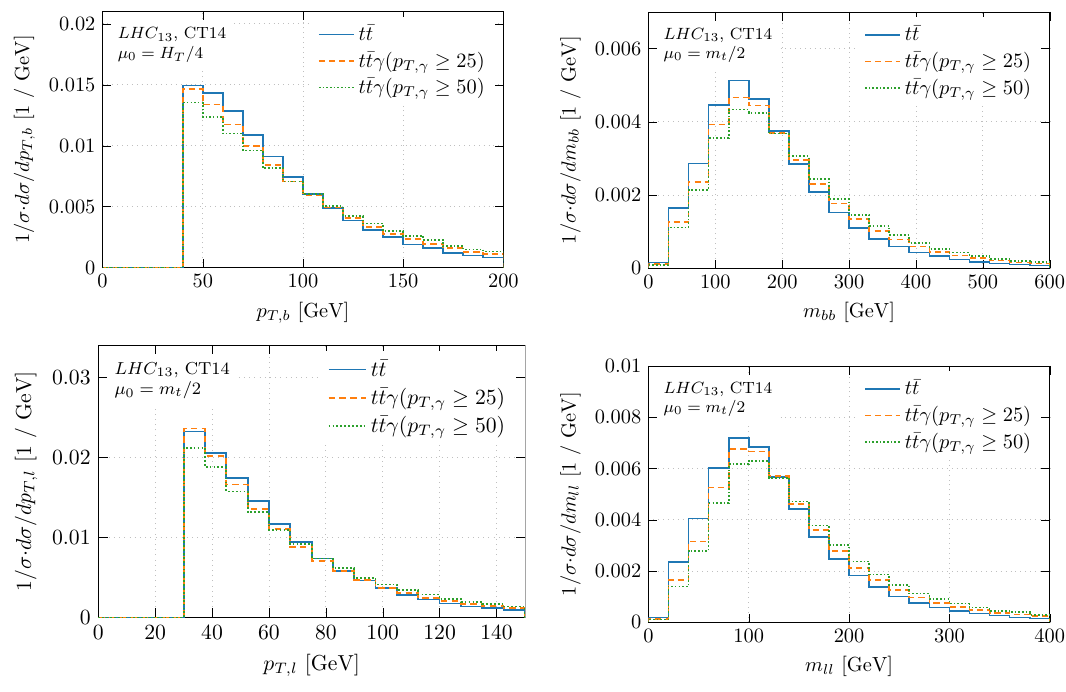
Figure 2 . Comparison of the normalised NLO di(cid:11)erential cross sections for pp and pp e + (cid:23) e (cid:22) (cid:0) (cid:22) (cid:23) (cid:22) b (cid:22) b + X at the LHC with p s = 13 TeV. The following distributions are shown: ! the averaged transverse momentum of the b -jet ( p T;b ), the invariant mass of two b -jets ( m bb ),